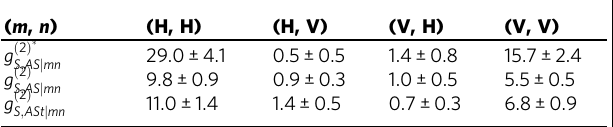
Table 3 The cross correlation functions. g ð 2 Þ are calculated from the main experimental data without and with QFC, respectively, while turning on the 850-nm laser light